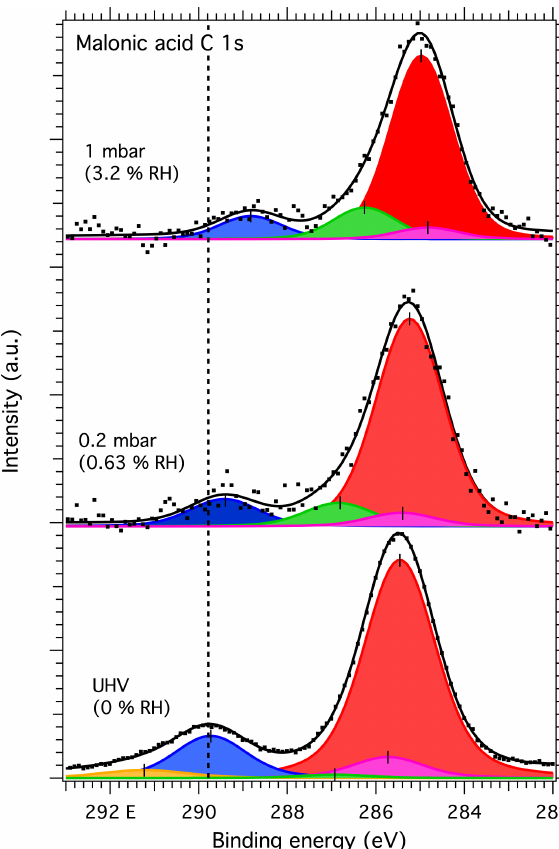
Figure 7. C 1s spectra of malonic acid aerosol particles. The dots show the recorded data and the solid lines the fit to the data. The blue and purple peaks correspond to COOH and C–C of malonic acid, respectively, while the yellow and green peaks correspond to DP1 and DP2 components, respectively, attributed to beam damage. The red peak corresponds to C–C / C–H of adventitious carbon. The dashed vertical line shows the binding energy of the COOH com- ponent at 0mbar pressure (0% RH) at the beginning of the experi- ments. Error bars show the estimated uncertainty in the peak posi- tion from Monte Carlo analysis. Photon energy was 1253.6eV from the Mg anode.